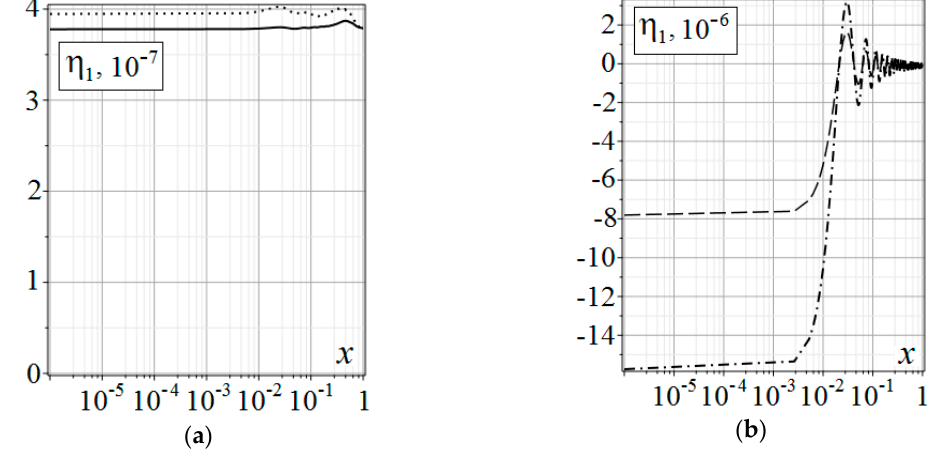
η on x . ( a ) Implantation; and ( b ) annealing. Figure 2. Concentration increment η 1 on x . ( a ) Implantation; and ( b ) Figure 2. Concentration increment 1